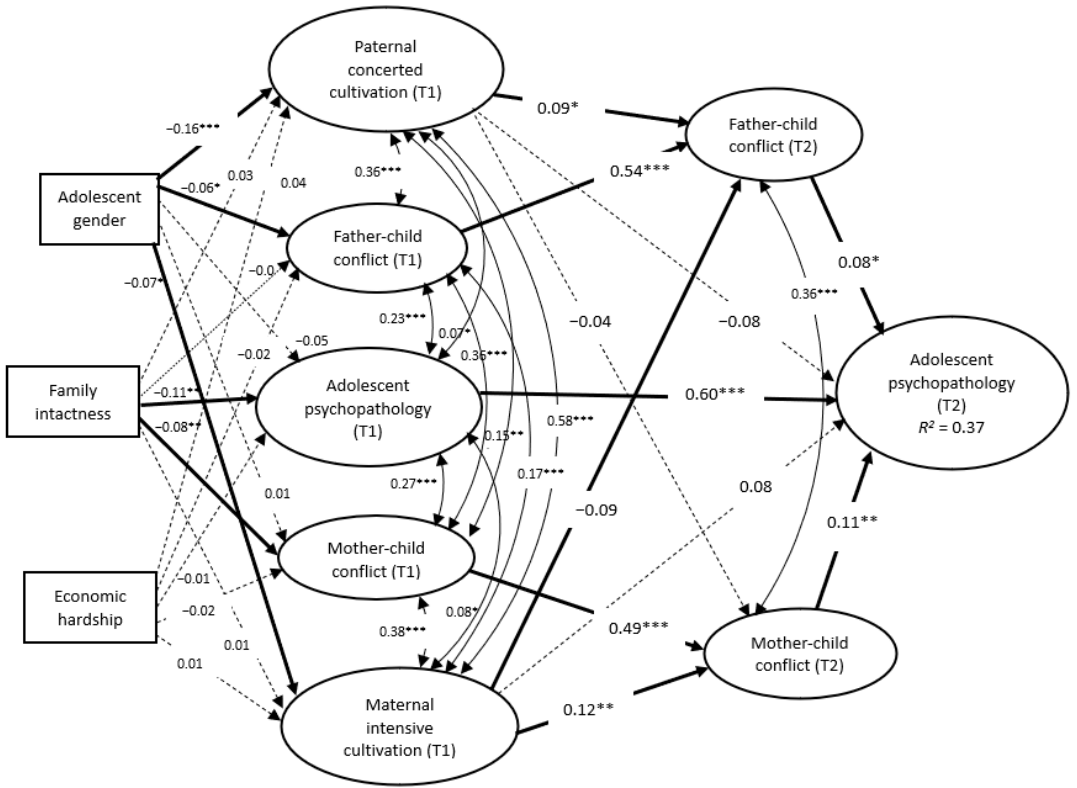
Figure 1. The final model of relationship among concerted cultivation, parent-child conflict and adolescent psychopathology. * p < 0.05, ** p < 0.01, *** p < 0.001. Note 1: Solid lines represent significant structural paths. Dotted lines represent non-significant structural paths.